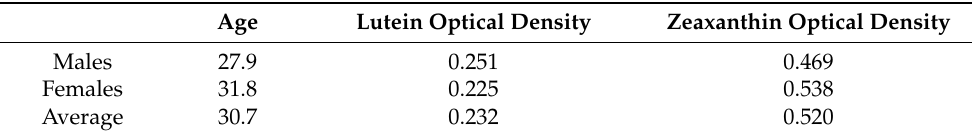
Table 10. Comparison of age, lutein and zeaxanthin optical density values of